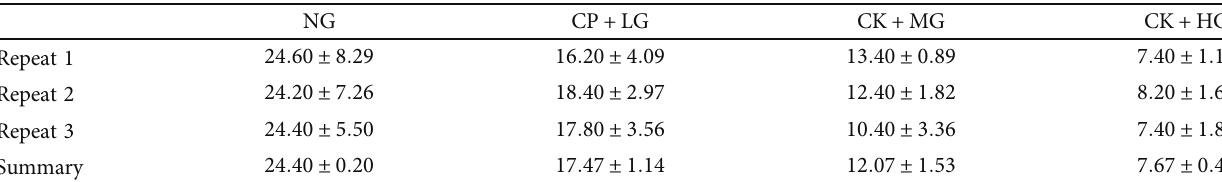
Table 2: Cell number statistics